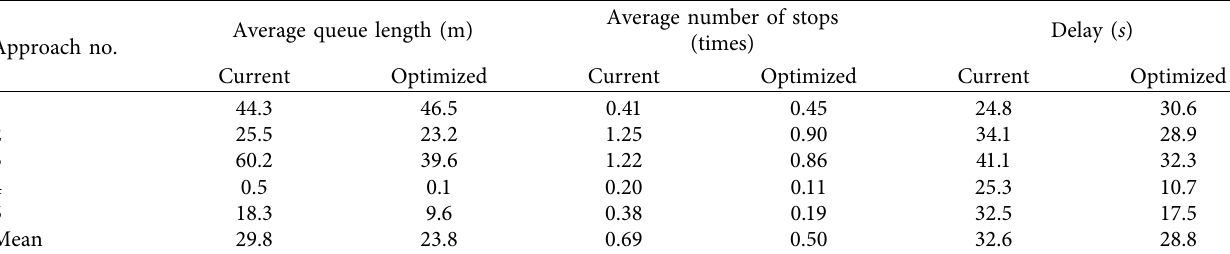
Table 9: Performance comparison results in cycle